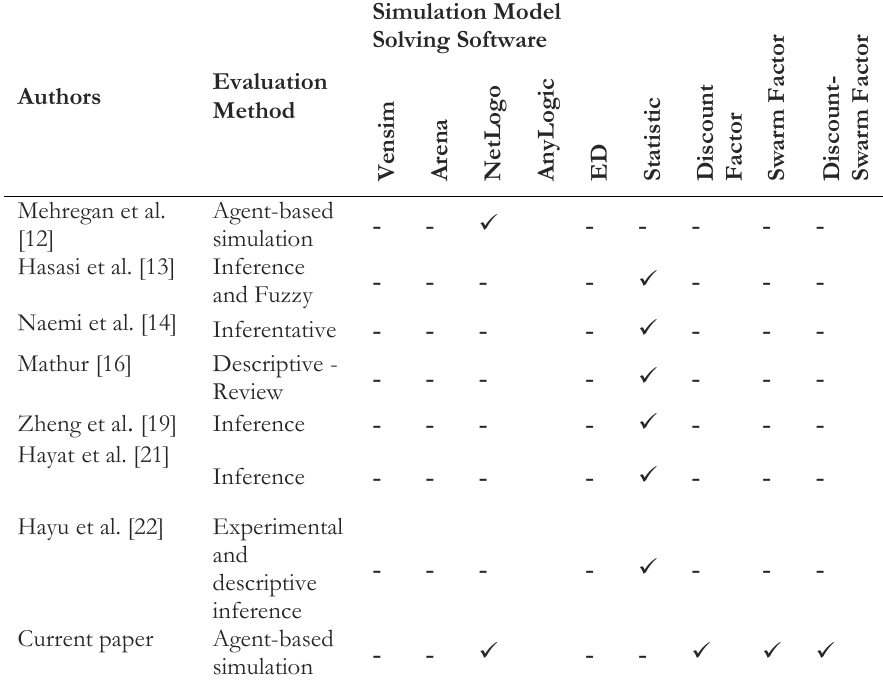
Table 2. Innovation of the present research compared to other researches (source: